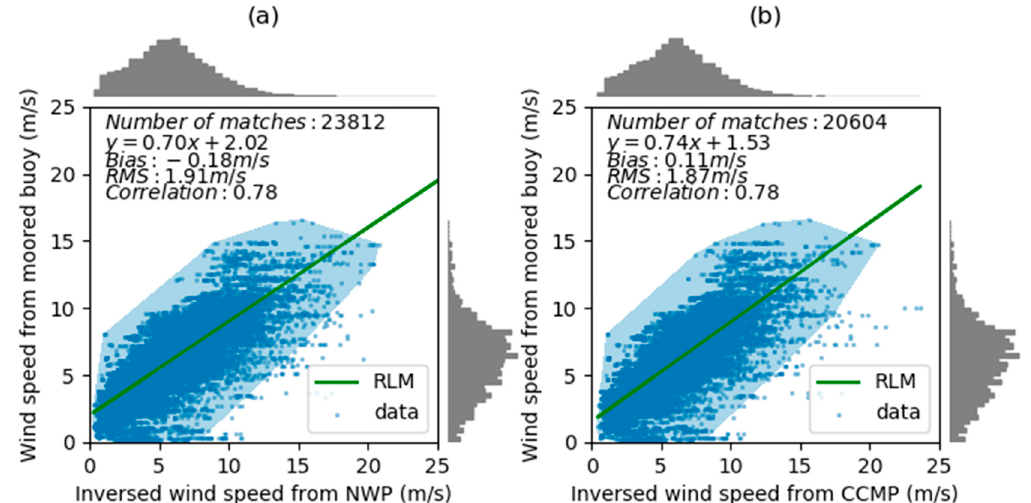
Figure 12. Retrieved wind speed from NWP-based ( a ) and CCMP-based surface truth wind ( b ) versus buoy wind speed. The gray histogram indicates the distribution of wind speed in testing samples, and statistics only compute samples less than four times of the standard deviation within the blue patch.